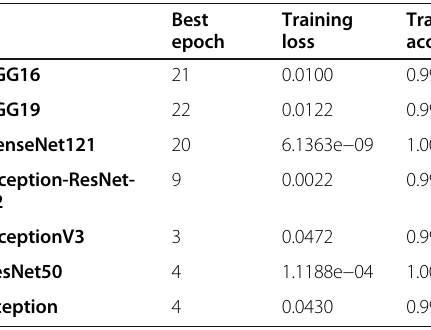
Table 3 Accuracy and loss during training and validation